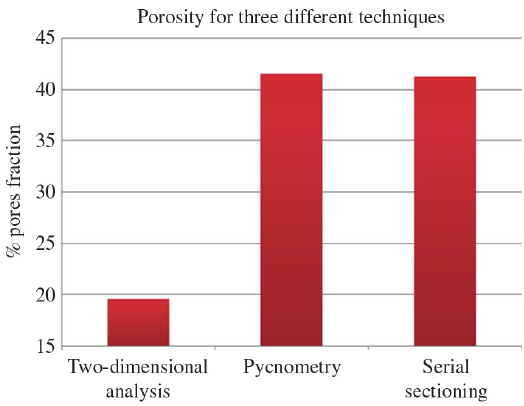
Figure 9. Porosity comparison among different